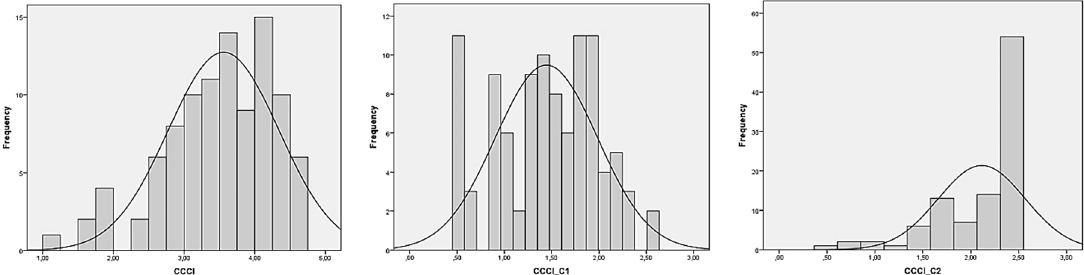
Figure 4. Distribution of values of CCCI, first component of CCCI, and second component of CCCI.